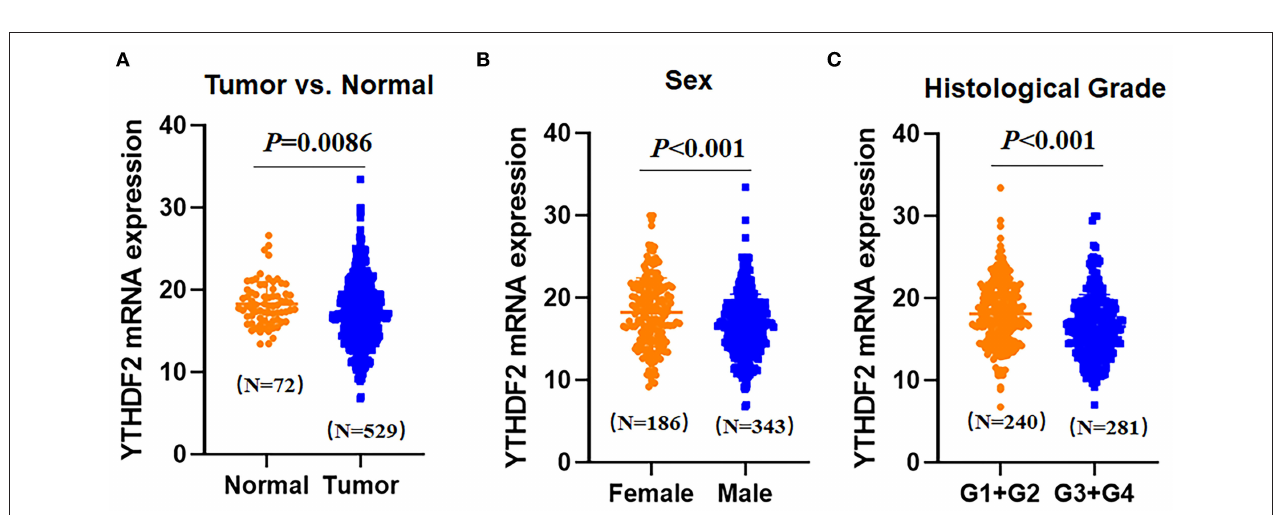
FIGURE 2 | Expression differences of YTHDF2 in clear cell renal cell cancer (ccRCC) samples and tumor-adjacent normal tissues (A) . Differential expression of YTHDF2 gene in ccRCC tissues ( N = 529) and tumor-adjacent normal tissues ( N = 72); (B) differential expression of YTHDF2 in female ( N = 186) and male ( N = 343) patients with ccRCC; and (C) differential expression of YTHDF2 gene between ccRCC tissues in lower histological grade (G1 + G2, N = 240) and higher histological grade (G3 + G4, N = 281).